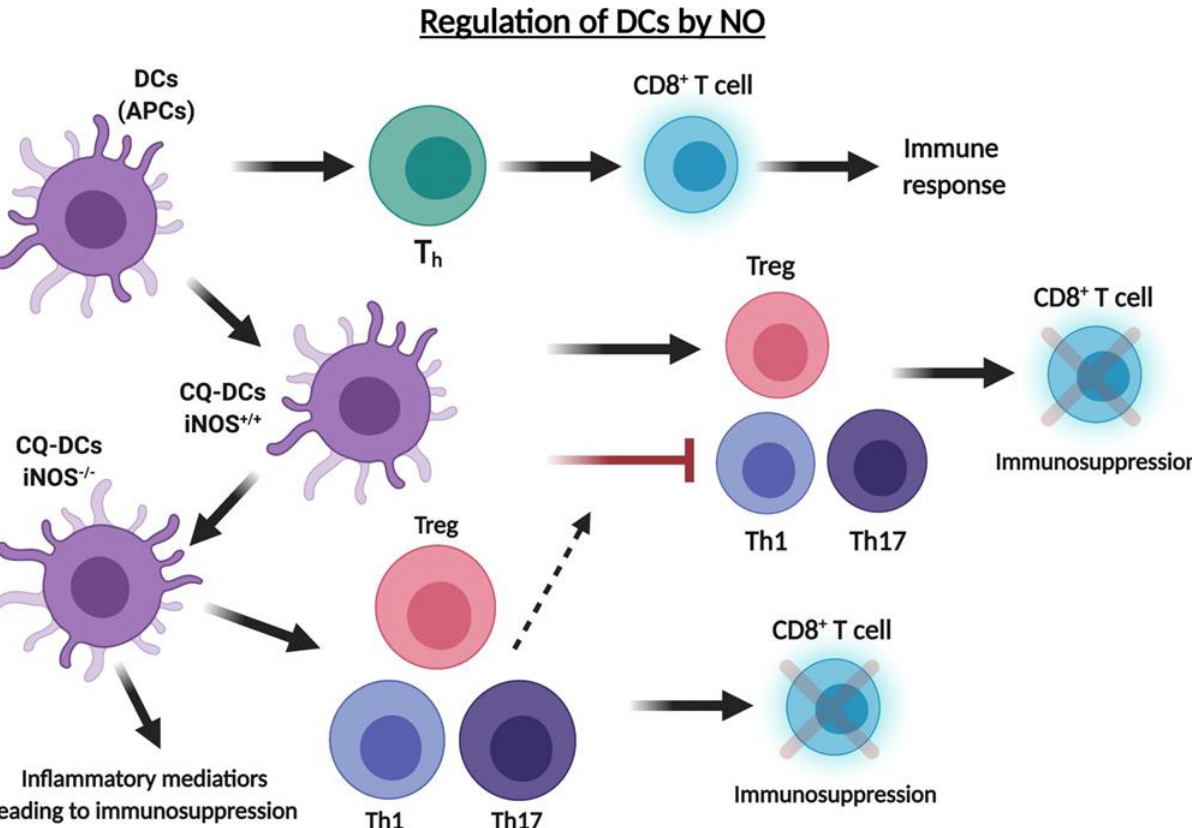
Figure 4. Regulation of DCs by .NO. Dendritic cells (DCs) act as antigen presenting cells to activate T helper cells to induce an immune response. Wild type chloroquine DCs (CQ-DCs) with iNOS +/+ promotes the activation of Tregs, which leads to CD8 T cell immunosuppression. Additionally, CQ-DCs simultaneously inhibit the differentiation of Th1/Th17 cells leading to immunosuppression. CQ-DCs with knockout iNOS promotes the differentiation of Treg, Th1 and Th17 cells leading to immunosuppression. They also result in the induction of inflammatory modulators to promote inflammatory tumor progression.